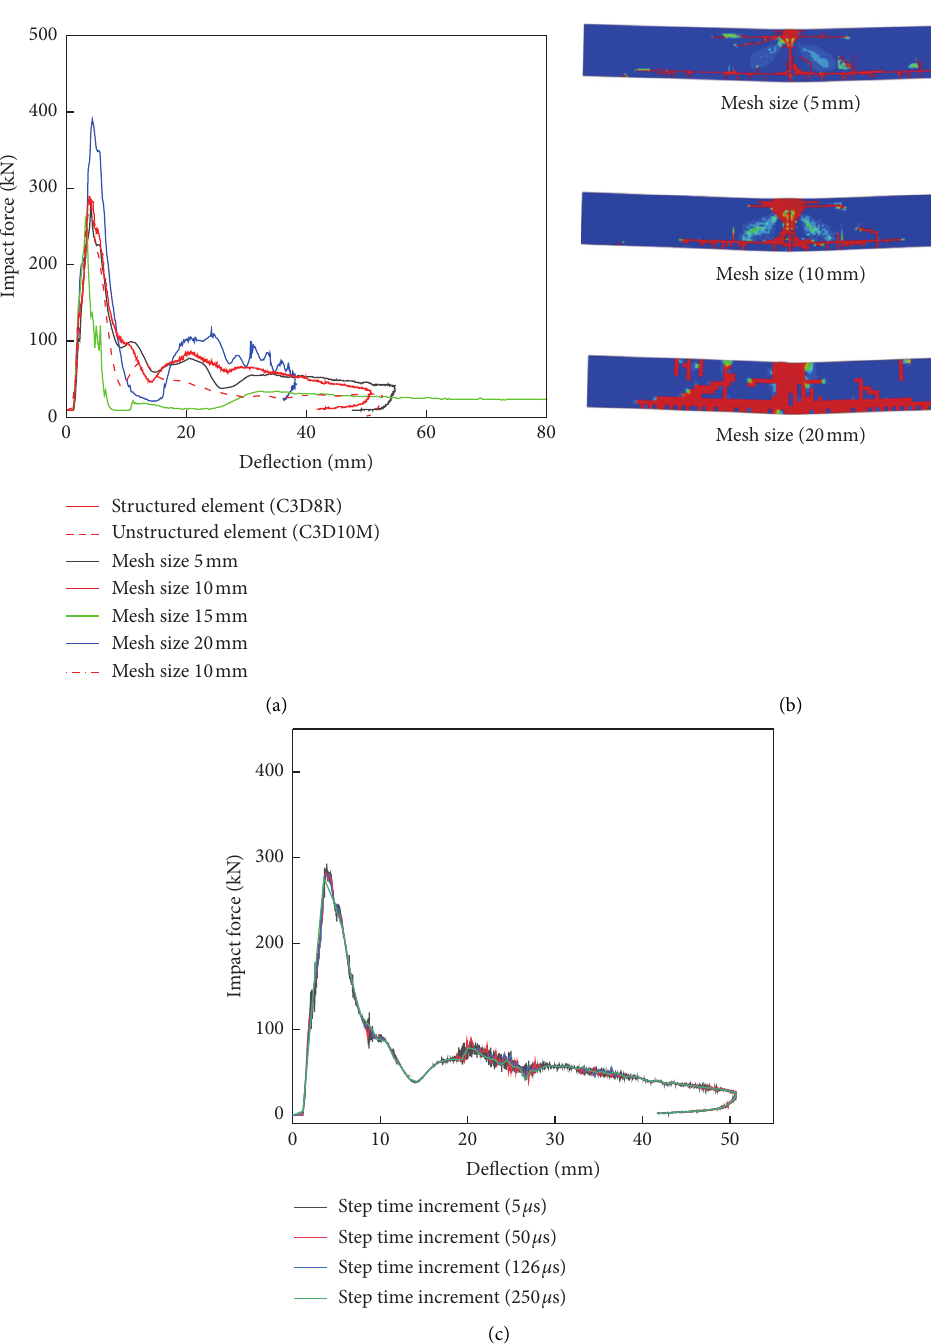
Figure 6: Comparison of a typical simulation with different discretizations. (a) The impact force-deflection curves for the RC beam with different mesh sizes. (b) Failure pattern for the structure with different mesh sizes. (c) The impact force-deflection curves for the RC beam with different step time